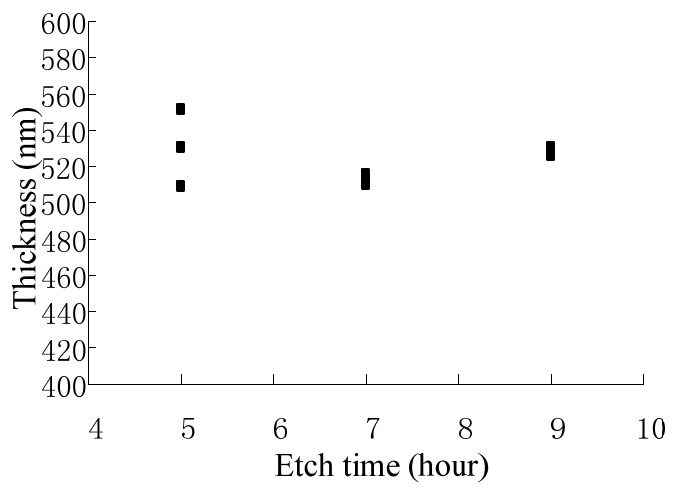
Figure 6. The thickness does not changes due to galvanic etch